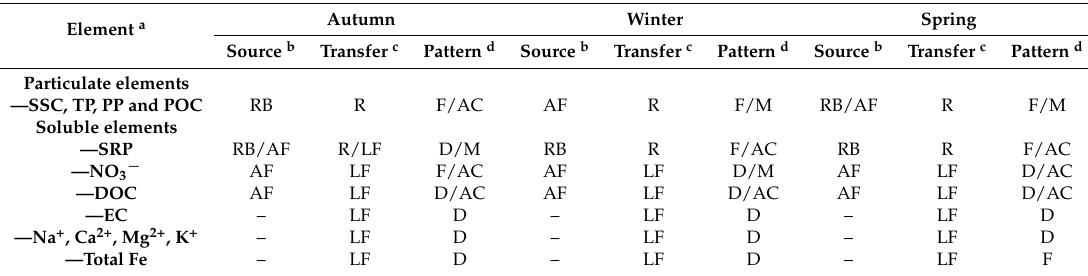
Table 2. Sediment and nutrients sources and main transport mechanisms in the Enxo é catchment. Element a